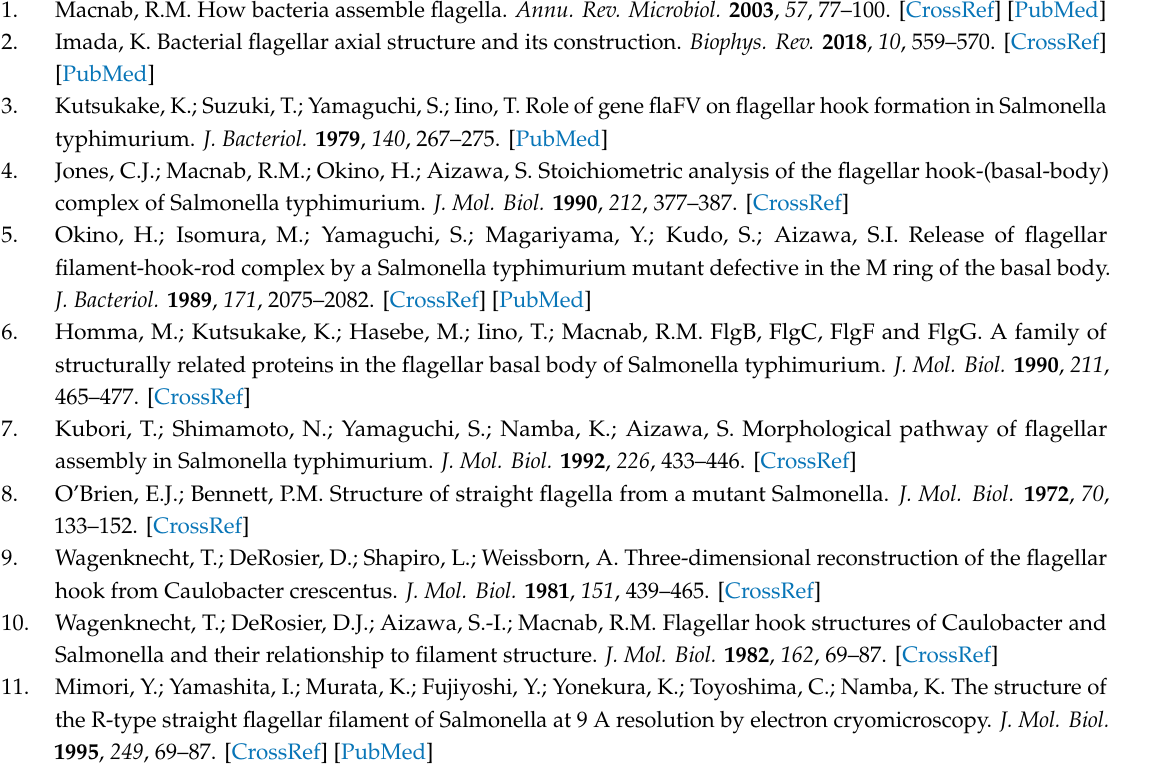
Figure S2: The rod model docked in the cryoEM map, Table S1: Key